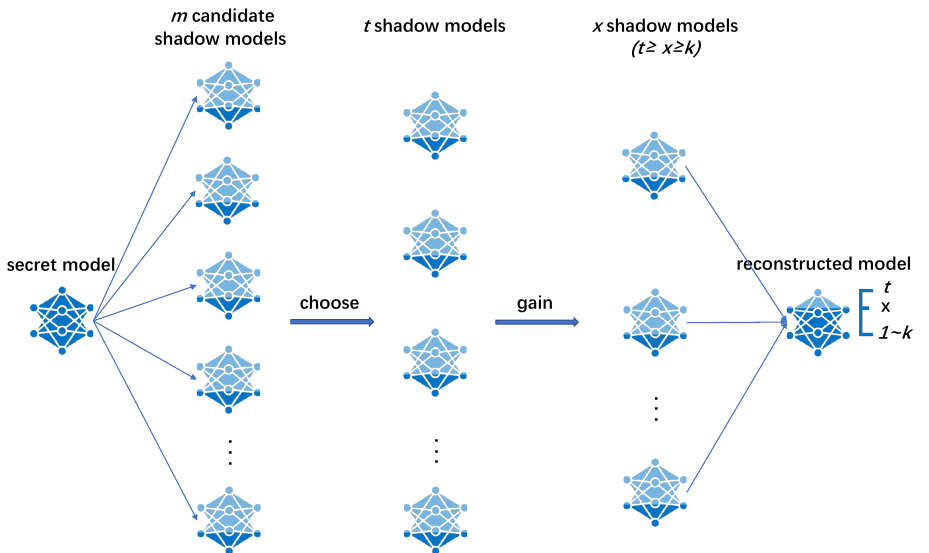
Figure 1. Workflow diagram of the NNSS scheme proposed in this